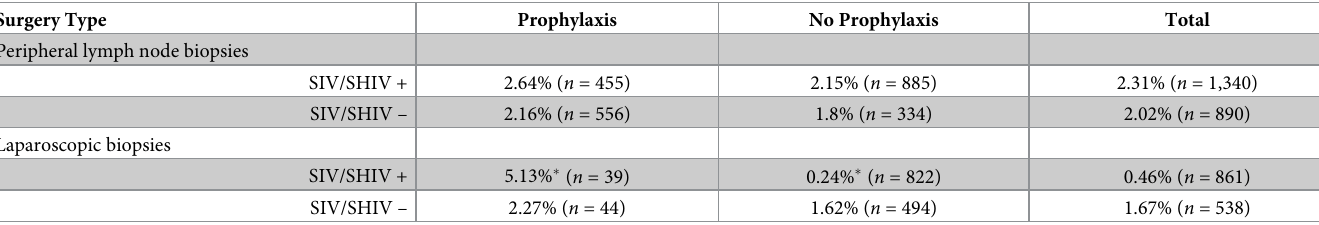
Table 3. Surgical complication rates based on infection status and treatment group. Surgery